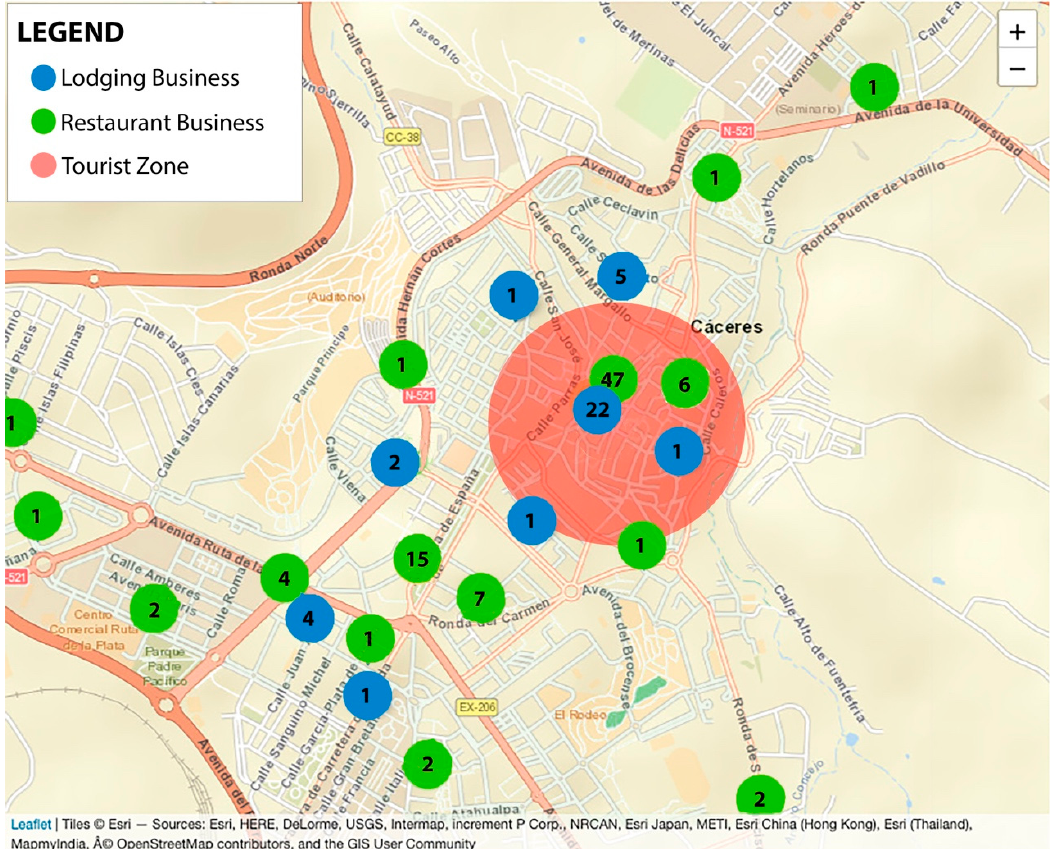
Figure 1 . Map of the city of Cáceres, with a number of hotel and restaurant services represented. Figure 1. Map of the city of C á ceres, with a number of hotel and restaurant services